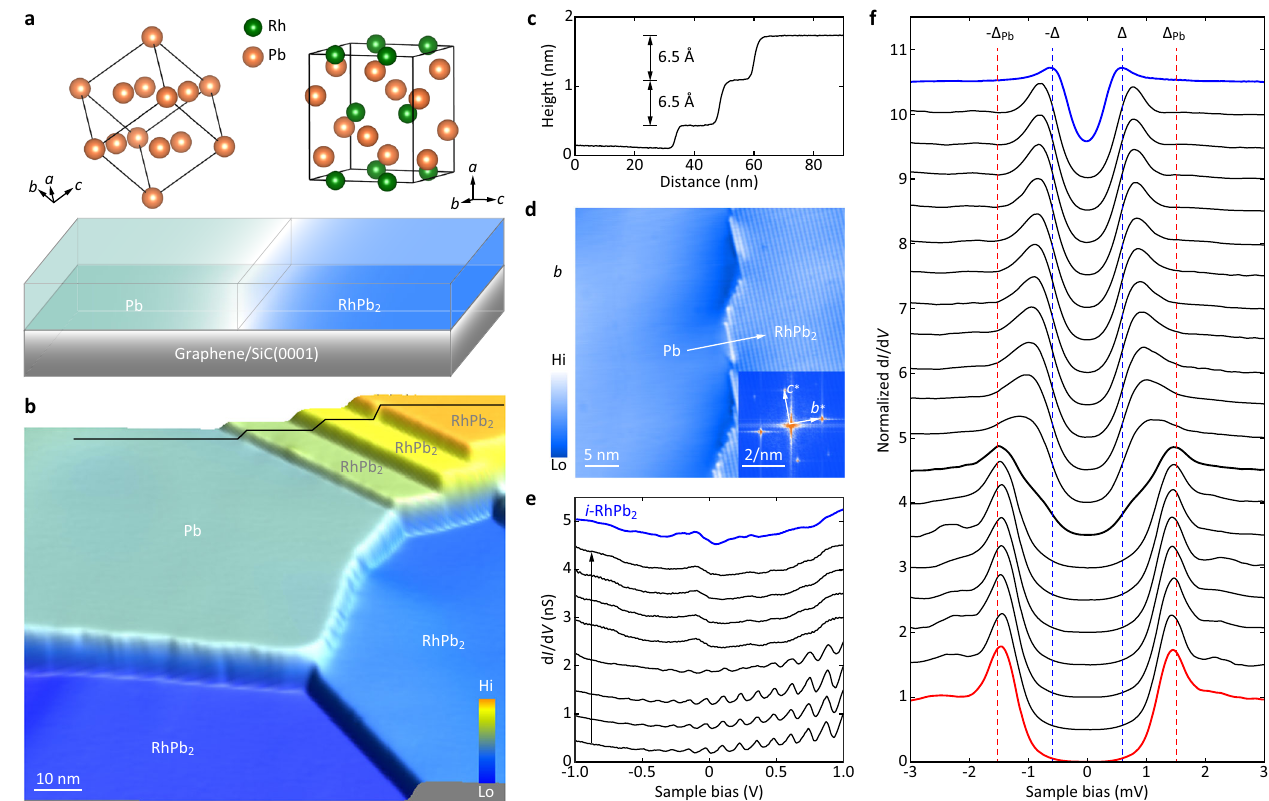
Fig. 1 Planar heterojunctions between two dissimilar superconductors Pb and RhPb2. a Schematic sketch of a planar Pb-RhPb 2 heterojunction on graphitized SiC(0001) substrate, with the respective crystal structure shown in the top panel. b Three-dimensional STM topographic image (100 nm × 100 nm, V = 4.0 V, I = 5 pA) of a representative Pb – RhPb 2 tricrystal heterojunction. As indicated, the Pb and RhPb 2 superconductor fi lms are well connected and form atomically sharp heterointerfaces. c Topographic pro fi le measured along the black trajectory across various terraces in ( b ). d Zoom-in STM topography (40 nm × 40 nm, V = 12 mV, I = 1 nA) showing the atomically sharp heterointerface between Pb and RhPb 2 . Insert shows a FFT image of the p -RhPb 2 surface, from which the in-plane lattice parameters of b = 6.8 Å and c = 5.9 Å are estimated by measuring the 2D reciprocal vectors b * and c *. e A series of d I /d V spectra (setpoint: V = 1.0 V, I = 500 pA) taken along the arrowed line from Pb to RhPb 2 in ( d ). The topmost d I /d V spectrum is acquired on i -RhPb 2 for comparison. f Low-energy-scale dI/d V spectra (setpoint: V = 4 mV, I = 500 pA) acquired at equal separations (4.6 nm), illustrating a spatial evolution of the superconducting gaps across a Pb/ RhPb 2 heterointerface. The bold curves are characteristic of i -RhPb 2 (blue), the Pb/RhPb 2 interface (black) and proximitized Pb (red), respectively. Vertical dashes mark the energy positions of the superconducting coherence peaks of intrinsic Pb (± Δ Pb , see the red ones) and Δ , blue ones) at 0.4 K. The spectra in e and f have been offset vertically on the d I /d V intensity axis for i -RhPb 2 (±